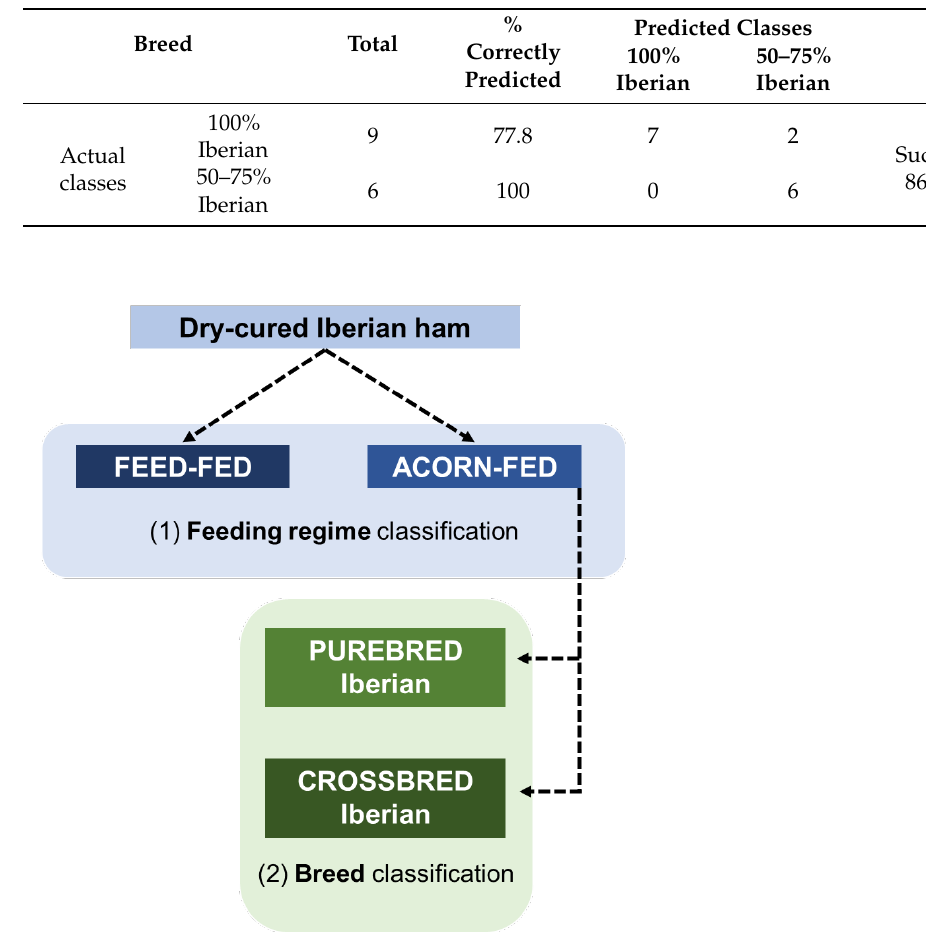
Figure 4. Procedure for Iberian ham classification in the industrial setting using the developed Raman